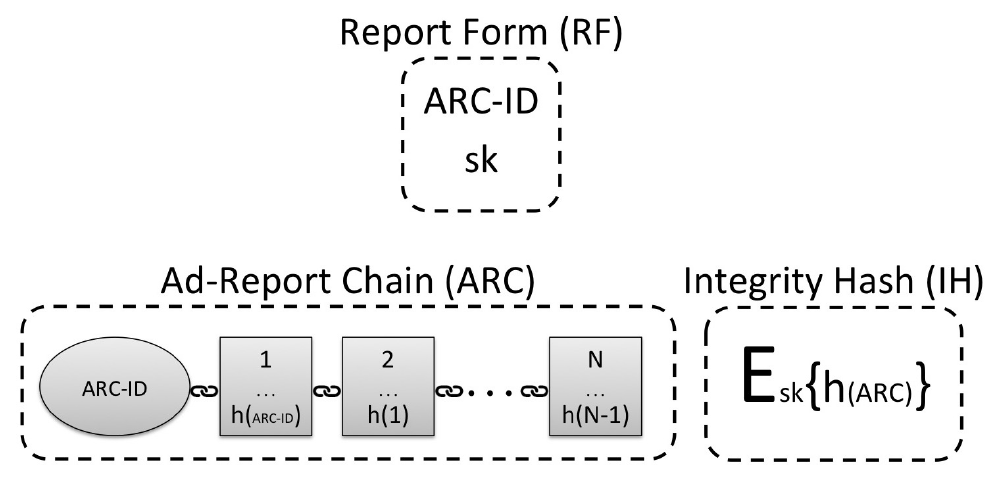
Figure 4. Structural elements of the Ad-Report